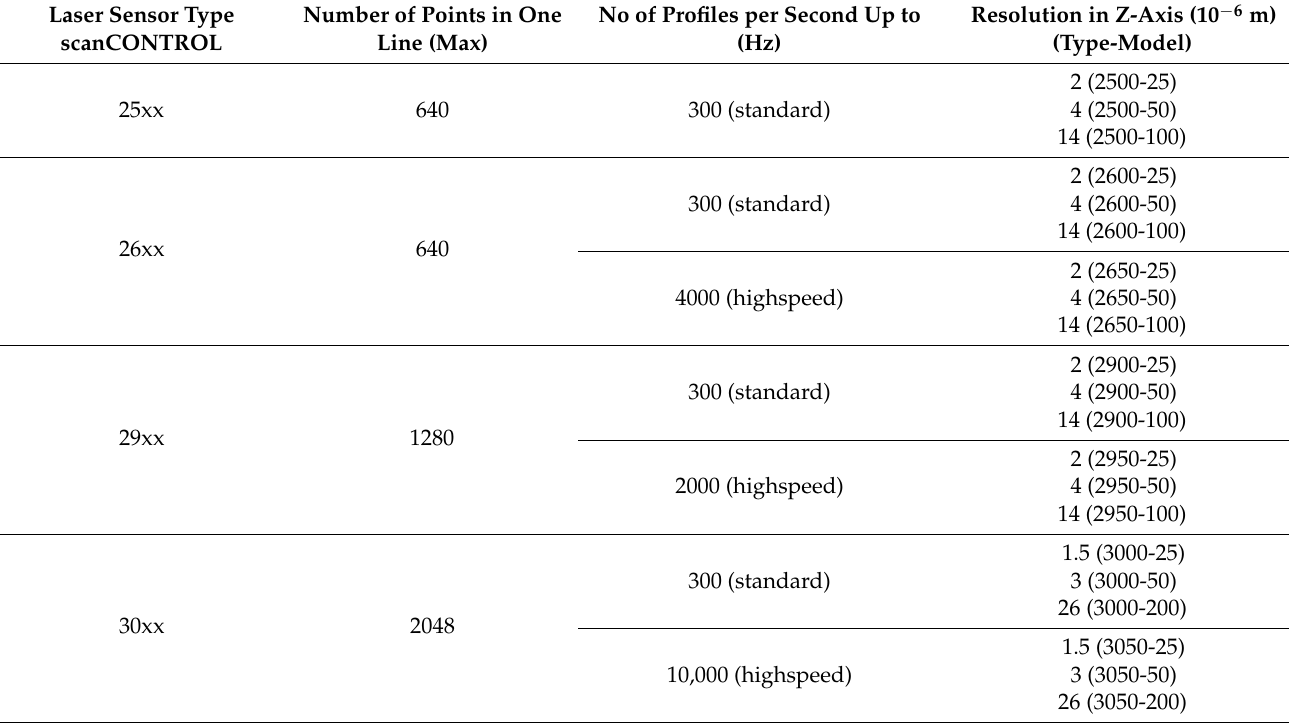
Table 1. Laser sensors Micro-Epsilon.